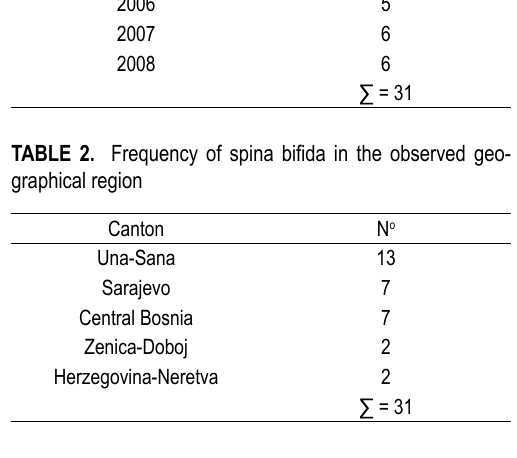
Table 3. Total number and gender of treated spina bifida